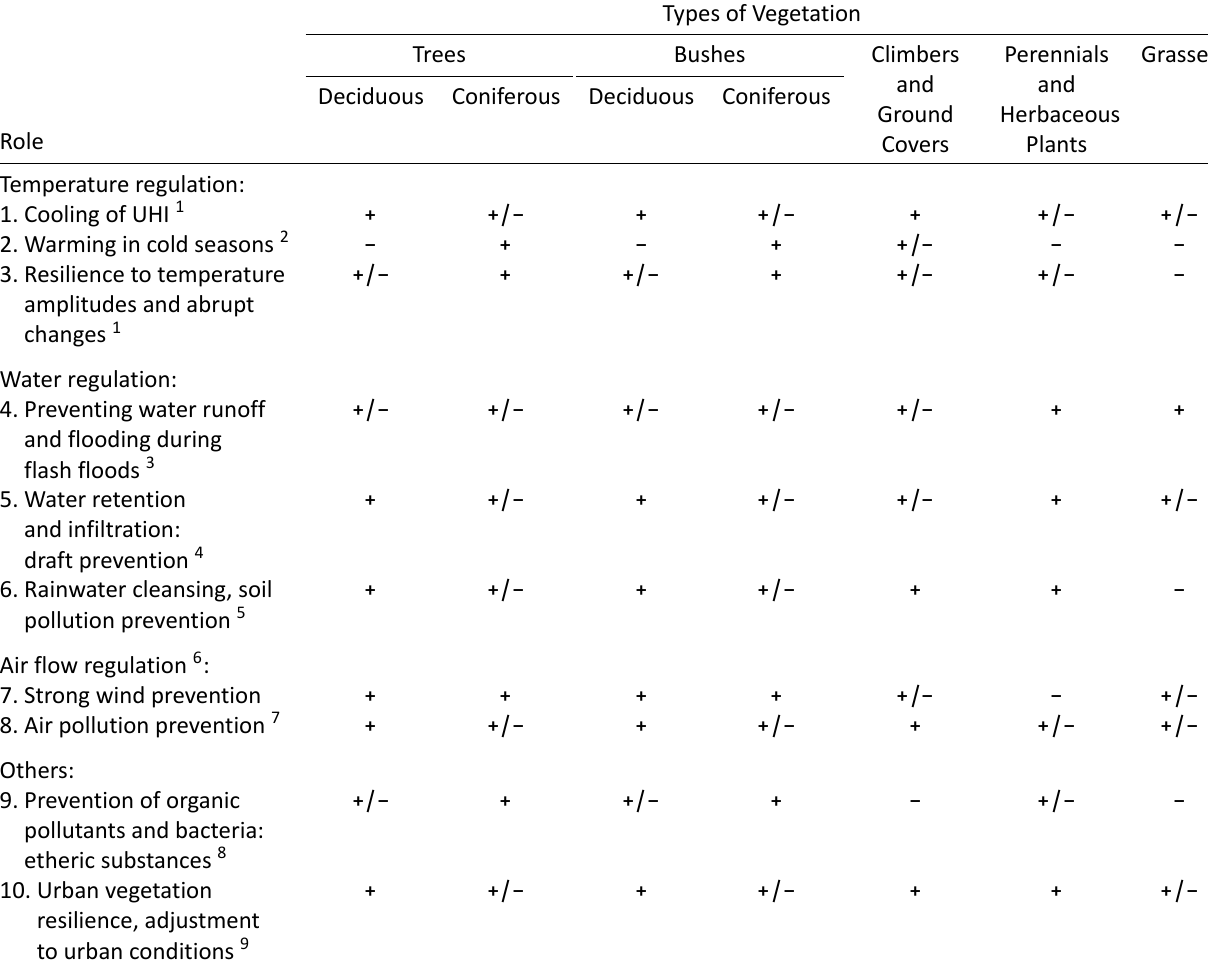
Table 2. Types of vegetation and their role in climate adaptation: + (influence), +/− (relative influence), and − (no influence).